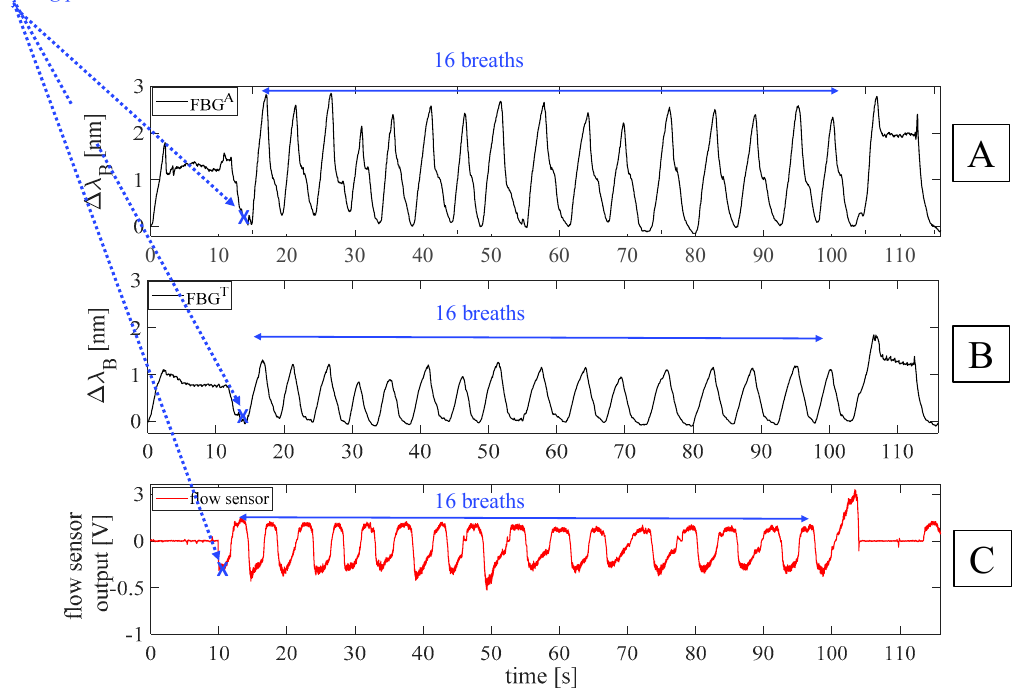
Figure 3. Outputs of the FBGs embedded into the smart textile and of the flow sensor on a whole experiment performed by a volunteer: ( A ) output changes of FBG A , placed in correspondence of the umbilicus; ( B ) output changes of FBG T , placed in correspondence of xiphoid process; ( C ) output of the flow sensor.